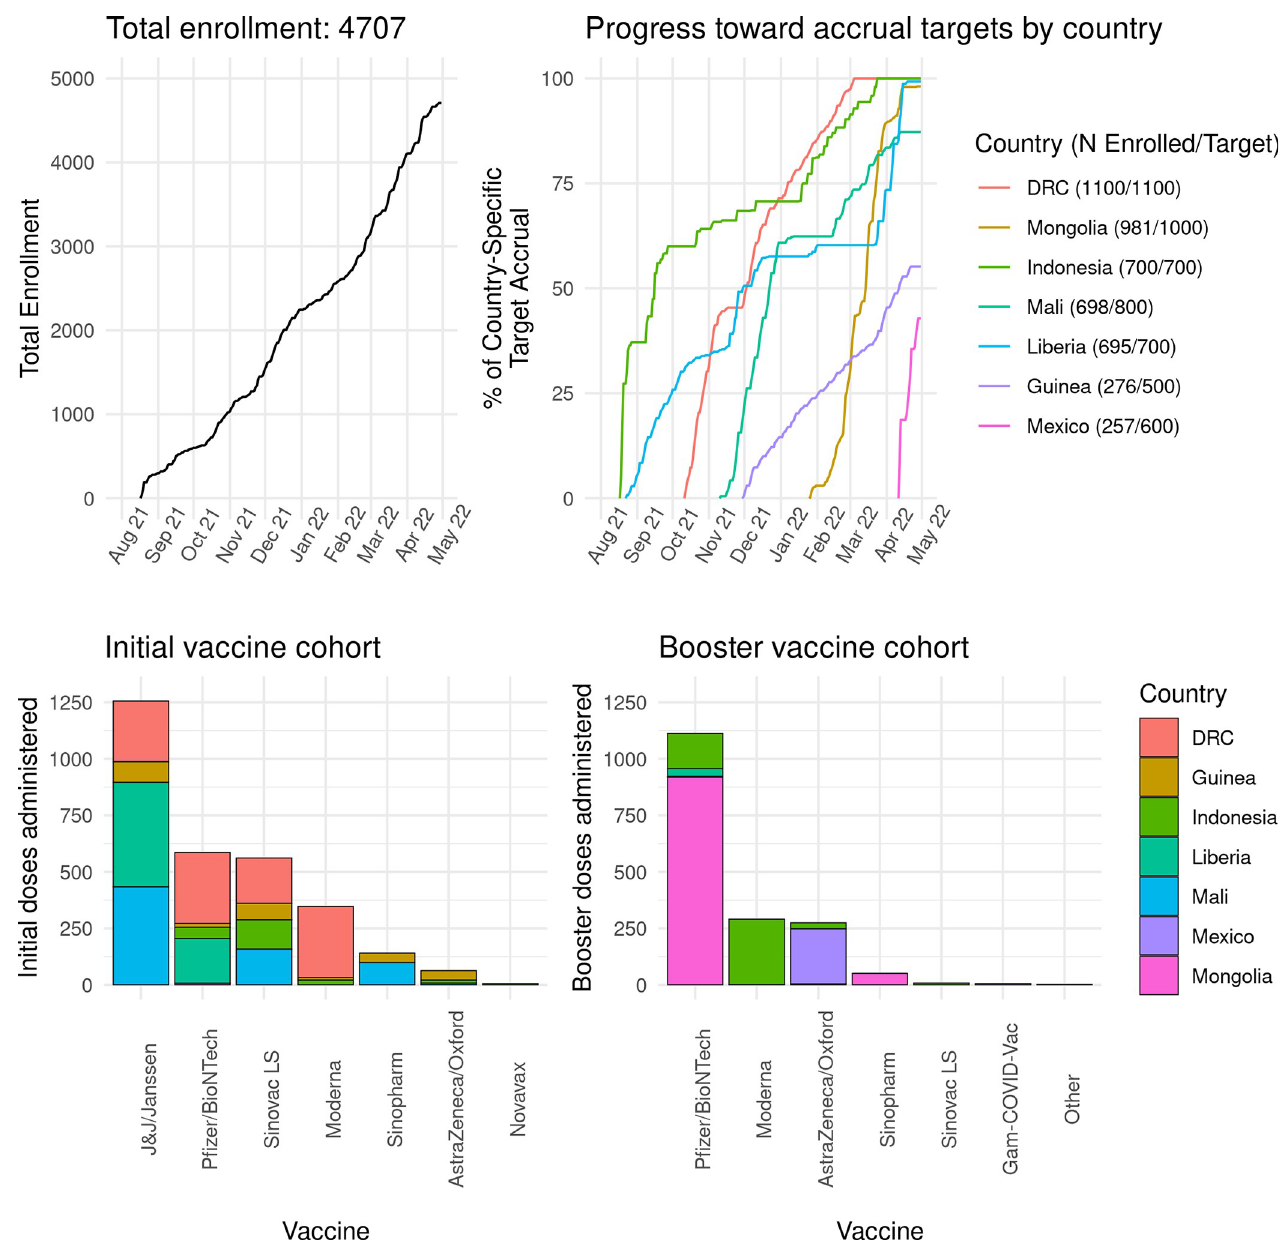
Fig 2. A. Current Enrollment Overall and by Country as of April 30, 2022. Analysis population includes participants with complete data on receipt of initial or booster vaccine regimen, Visit 1 date, and manufacturer of first vaccine who met all eligibility criteria, provided informed consent within one day of receiving a COVID-19 vaccine, and were deemed eligible to continue to Visit 2. Data cleaning is ongoing as the study continues. B. Vaccines Received to Date in the Initial and Booster Cohorts as of April 30, 2022. Analysis population includes participants with complete data on receipt of initial or booster vaccine regimen, Visit 1 date, and manufacturer of first vaccine who also met all eligibility criteria, provided informed consent within one day of receiving a COVID-19 vaccine, and were deemed eligible to continue to Visit 2. Data cleaning is ongoing as the study